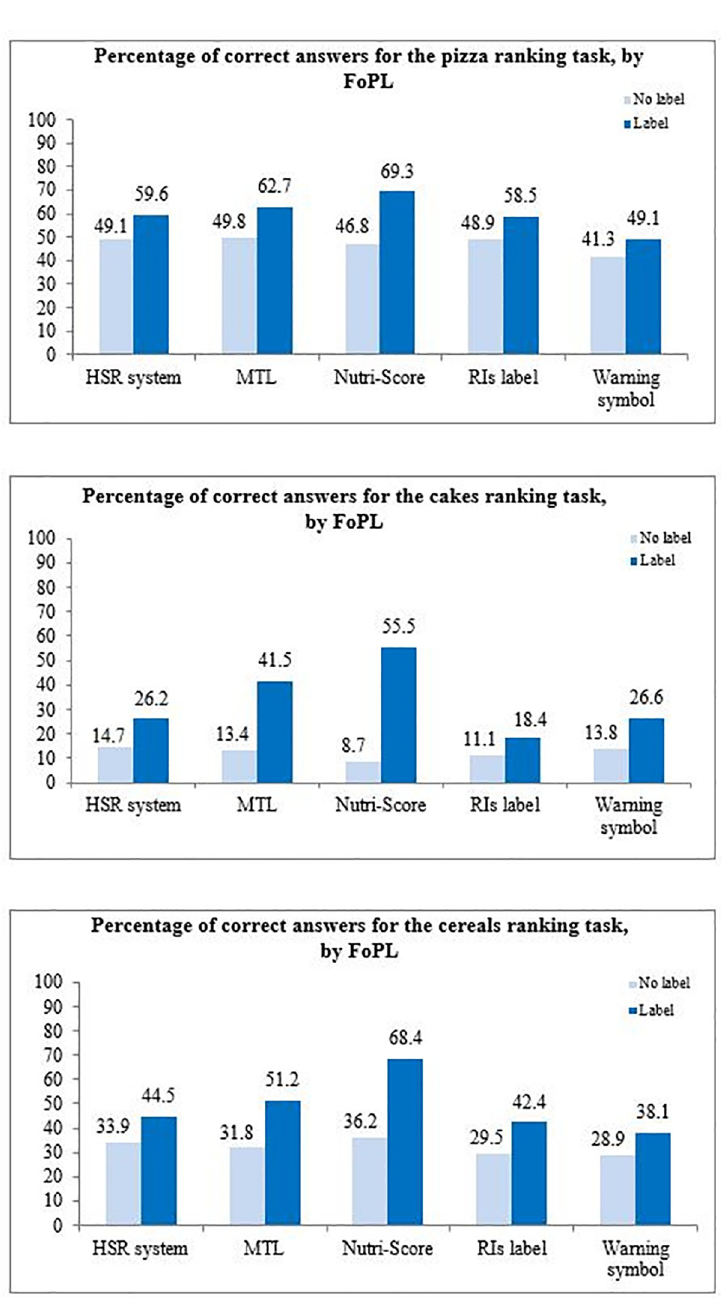
Fig 4. Percentage of correct answers for ranking tasks, by FoPL and food category. Associations between FoPL type and ability to correctly rank products are presented in Table 3 . Overall, the Nutri-Score was the label leading to the greatest improvement in ability to correctly rank products according to their nutritional quality compared to the RIs (OR = 4.02[2.81–5.75] (p-value < 0.0001), followed by the MTL (OR = 2.09[1.46–2.99], p-value < 0.0001) and the Warning symbol (OR = 1.52[1.05–2.18], p-value = 0.03). When analyses were performed by food category, the Nutri- Score showed higher performances among the three categories, and was notably the only FoPL to show significant improvements compared to the RIs label among pizzas and breakfast cereals. Among cakes, the performance of the Nutri-Score was followed by the MTL, the Warning symbol and then the HSR.